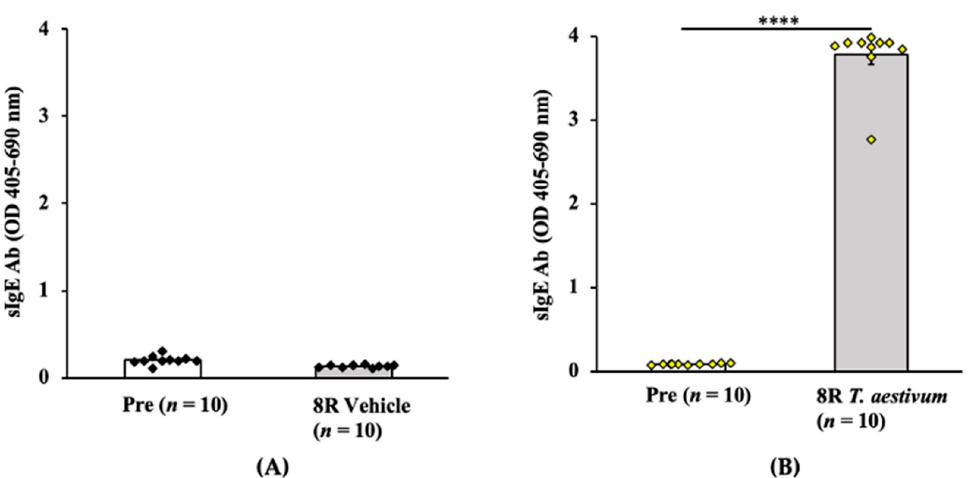
Figure 4. Transdermal exposure of Balb/c mice to SSPE from Triticum aestivum (genomes AABBDD) elicited robust specific (s) IgE antibody responses. Mice were exposed to T. aestivum SSPE, or saline as described in Methods. Plasma collected before the 1st exposure (Pre) and after the 8th exposure (8R) was used in the measurement of sIgE levels (OD 405–690 nm). ( A ) sIgE levels in control mice. ( B ) sIgE levels in sensitized mice. **** p < 0.001, student’s t -test. Ab: antibody, n : number of mice, SSPE: salt-soluble protein